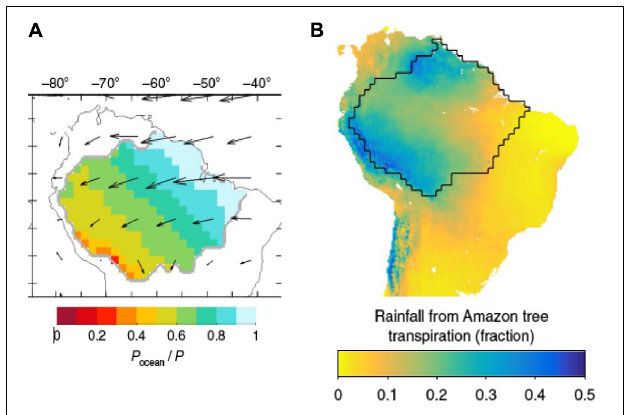
FIGURE 4 | (A) Fraction of total precipitation during the extended dry season (June–November) that last evaporated from the ocean, calculated from atmospheric moisture tracking (1989–2005). Arrows represent vertically integrated moisture fluxes. Source: Zemp et al. (2017), © Nature Communications. CC licence. (B) Fraction of mean annual rainfall that has been transpired by trees in the Amazon basin. Source: Staal et al. (2018). © Nature Climate Change. Reprinted by permission from Springer